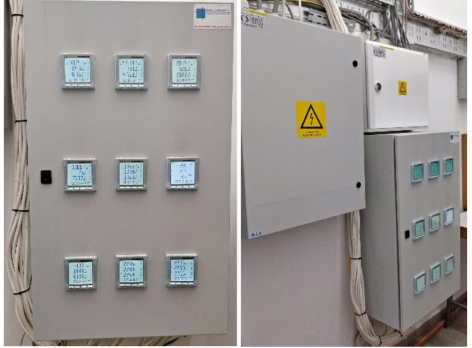
Figure 6. The monitoring panel of the PV system with nine digital electric